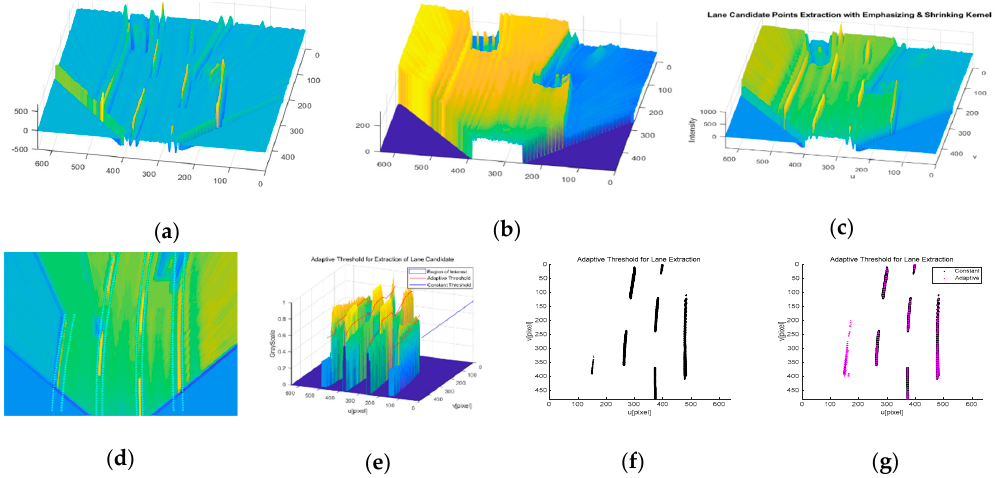
Figure 7. A robust lane feature extraction method, ( a ) emphasizing lane features (indicated by brightness), ( b ) shrinking the road region (darkness), ( c ) combining the two kernels, ( d ) frame level multi-lane region of interest (ROI), ( e ) reconstruction of the shadowy region features with a